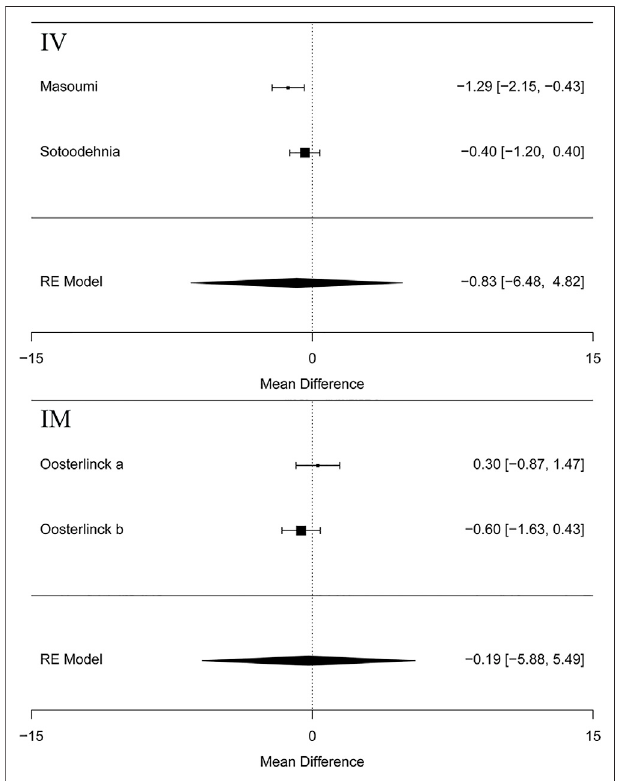
FIGURE 5 | The results of meta-analysis for pain scores (VAS) at 60 min based on different